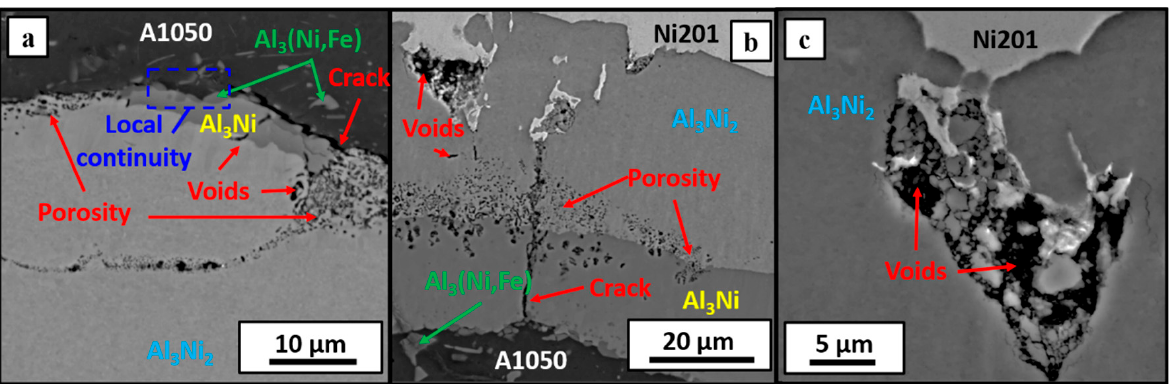
Figure 9. Defects of the welds occurring at the interface after annealing at 500 °C for 24h for the explosive welds obtained at 2000 m/s ( a ), 2800 m/s ( b , c ) detonation velocity.